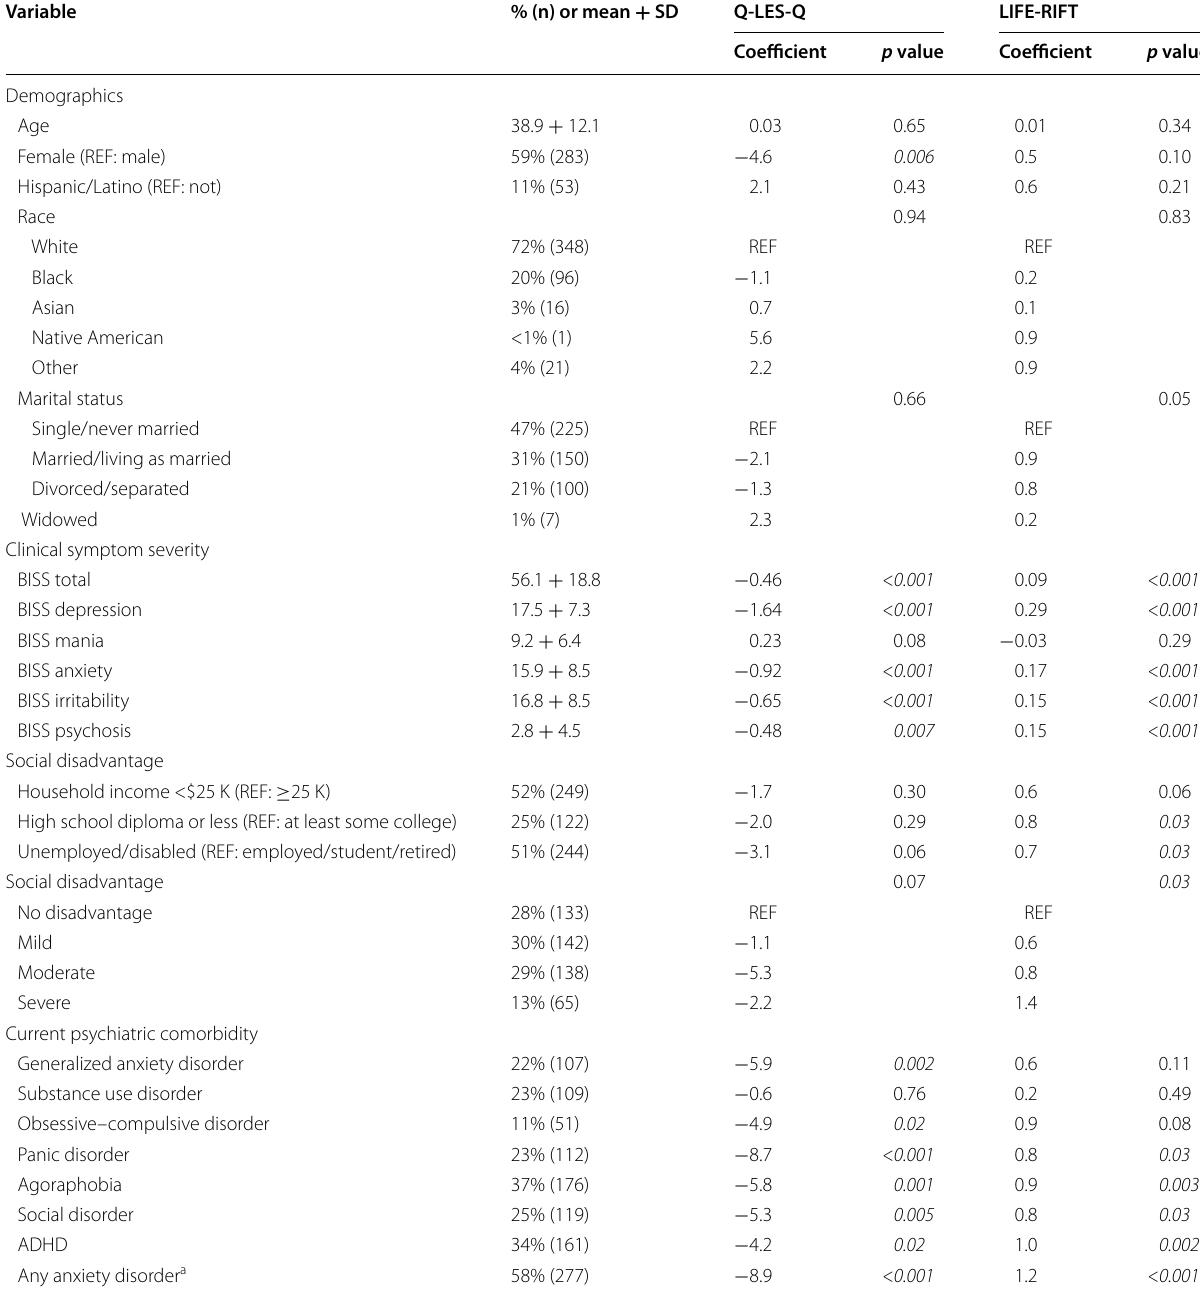
Table 1 Baseline correlations of quality of life and functioning with demographics, clinical severity, social disadvantage, and current psychiatric